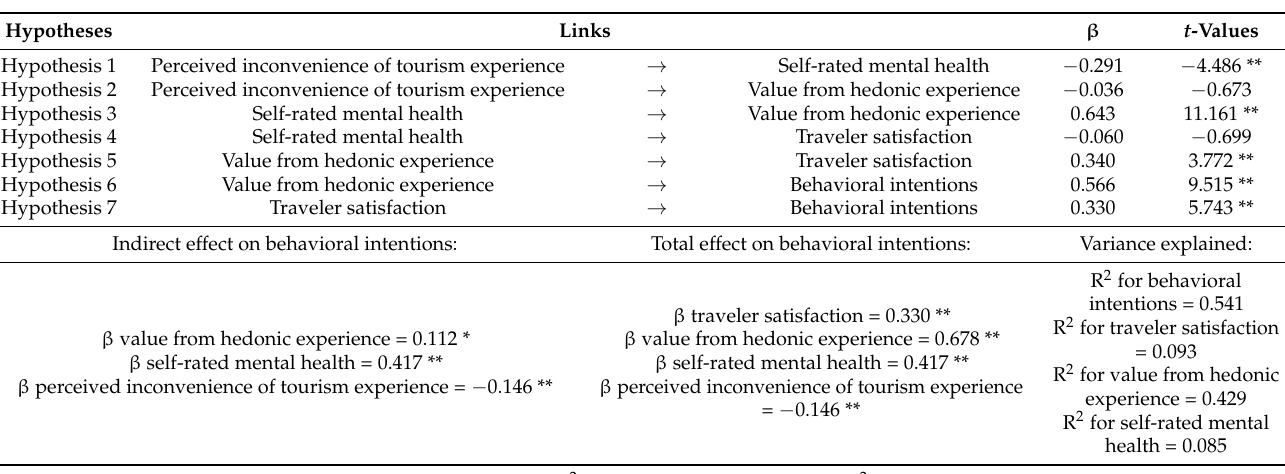
Table 2. The structural model